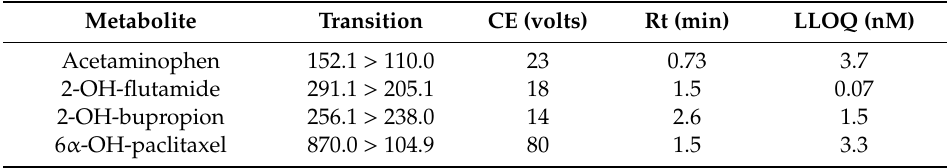
Table 2. Ultra-performance liquid chromatography tandem mass spectrometry system (UPLC-MS / MS) parameters for metabolites of the drug-metabolizing enzyme selective substrates. Legend: CE, collision energy; Rt, retention time; LLOQ, lower limit of